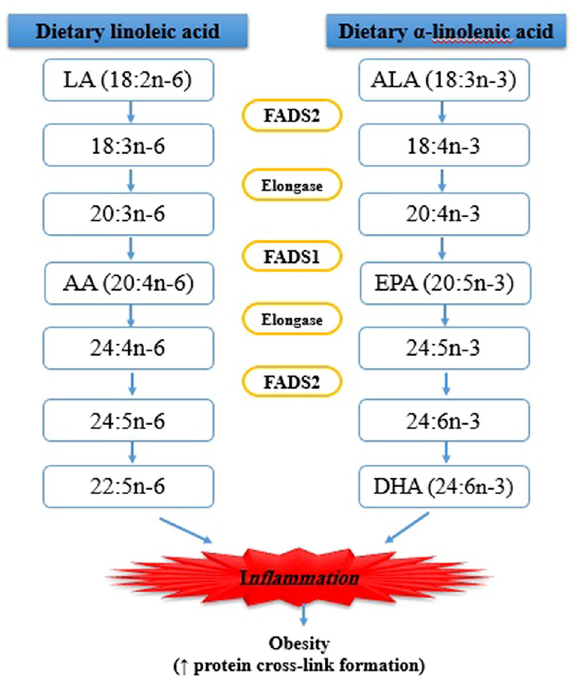
Figure1. Mechanisms of AGEs involved in obesity